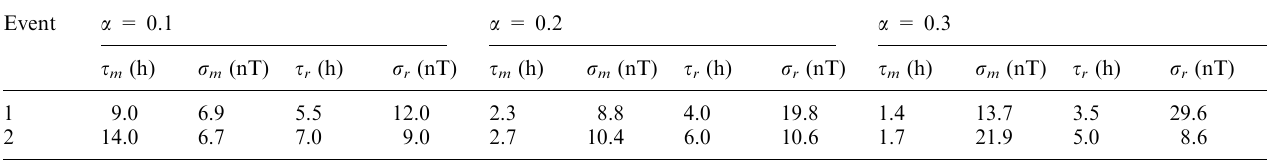
Table 3. Best-fit results from the balance equation numerical integration (see Appendix). The decay times found for the main phase ( s = s ) and for the recovery phase ( s m the respective standard deviation (in nT) derived from Eq. (A1) Event a =